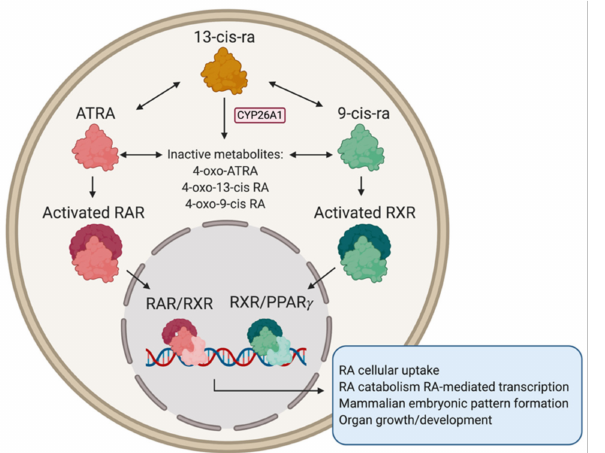
Figure 2. Signalling cascade of RA isoforms. Created with BioRender.com (accessed on 9 Febru- ary